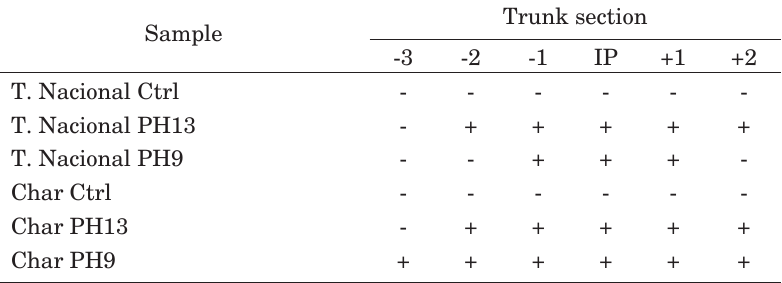
1. Occurrence of infection in trunk tissue from plants from cv. Touriga Nacional (T. Nacional) and cv. Chardonnay (Char) challenged with Pa. chlamydospora strains PH9 and PH13. Results from control plants (Ctrl) are also shown. Distance expressed in cm above (+) and below (-) the inoculation point (IP) section (1 cm).